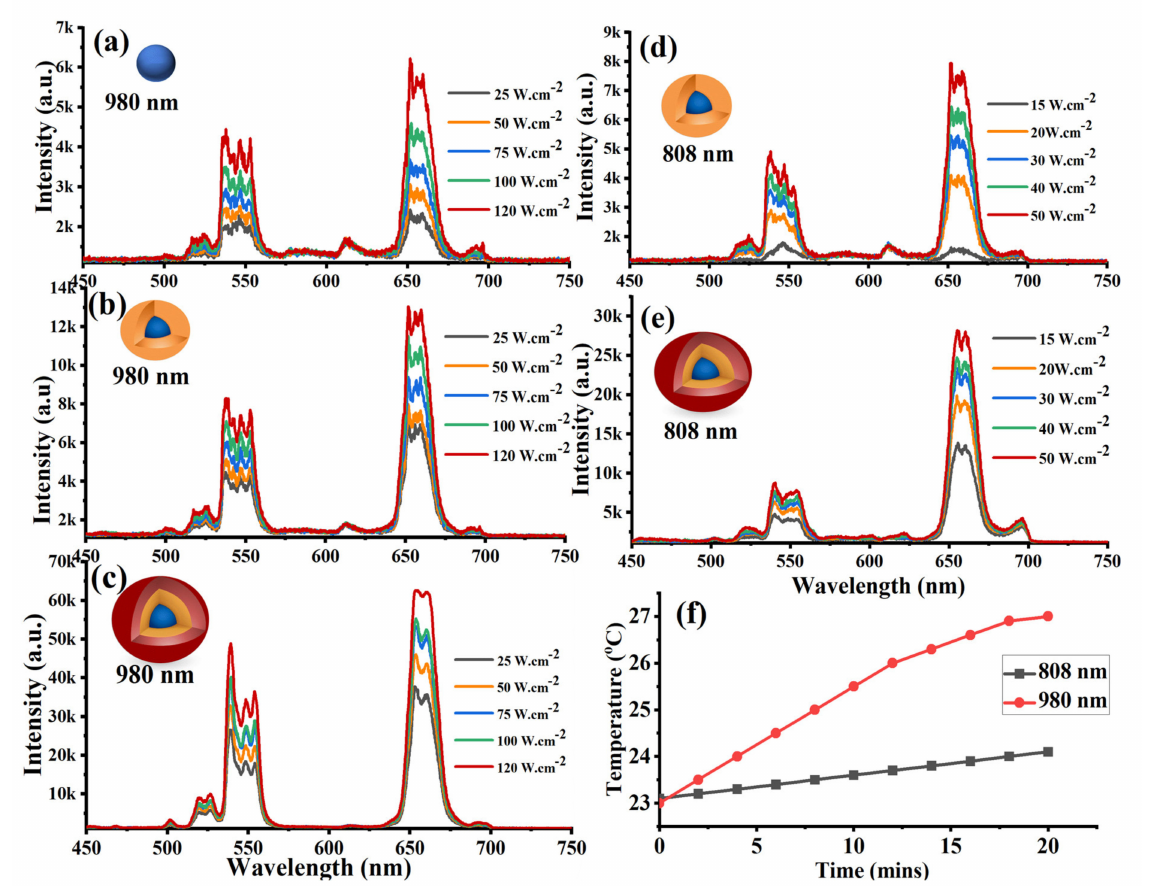
Figure 3. Upconversion luminescence spectra (UCL) of ( a ) core particles NaGdF 4 :Yb (20%) and Er(8%). ( b ) Core–shell particles NaGdF 4 :Yb (20%) and Er (8%)@ NaYb 0.90 F 4 :Nd (10%). ( c ) Core–shell–shell particles NaGdF 4 :Yb (20%) and Er (8%)@ NaYb 0.90 F 4 :Nd (10%) @ NaYF 4 UCNP particles under 980 nm laser excitation at different laser intensities. UCL of ( d ) core–shell particles NaGdF 4 :Yb (20%) and Er (8%)@ NaYb 0.90 F 4 :Nd (10%). ( e ) Core–shell–shell particles NaGdF 4 :Yb (20%) and Er (8%)@NaYb 0.90 F 4 :Nd (10%)@ NaYF 4 UCNP particles under 808 nm laser excitation at different laser intensities. ( f ) Comparison of temperature rise of 1 mg/mL CSS-PAA UCNPs dispersed in 2 mL of distilled water under 808 and 980 nm laser irradiation at 50 W · cm − 2 for 20